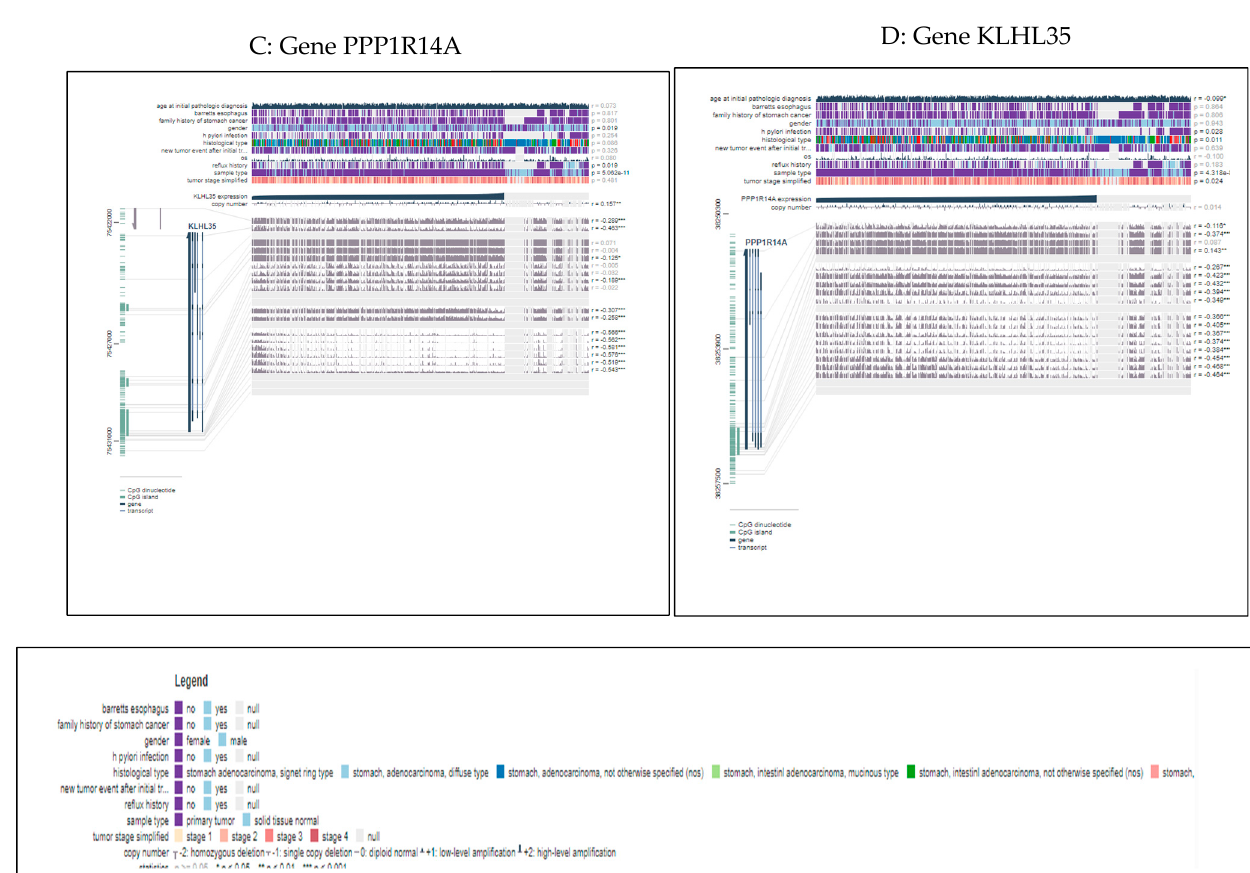
Figure 10. The results of correlation between various factors and gene expression, especially the relationship of gene methylation levels and expression level. ( A ) Gene NOL6 ( B ) Gene: FEZF1 ( C ) Gene PPP1R14A ( D ) Gene KLHL35